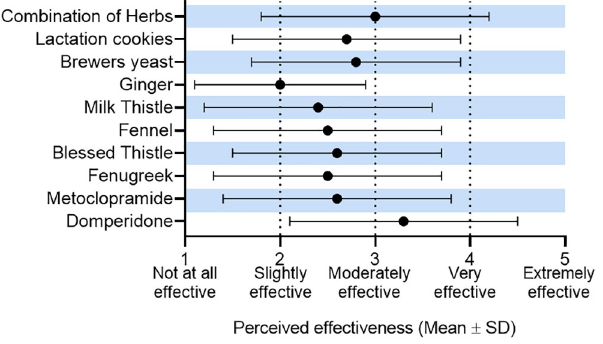
Fig 3. Perceived effectiveness of galactagogues used by women who were breastfeeding (n = 1120).